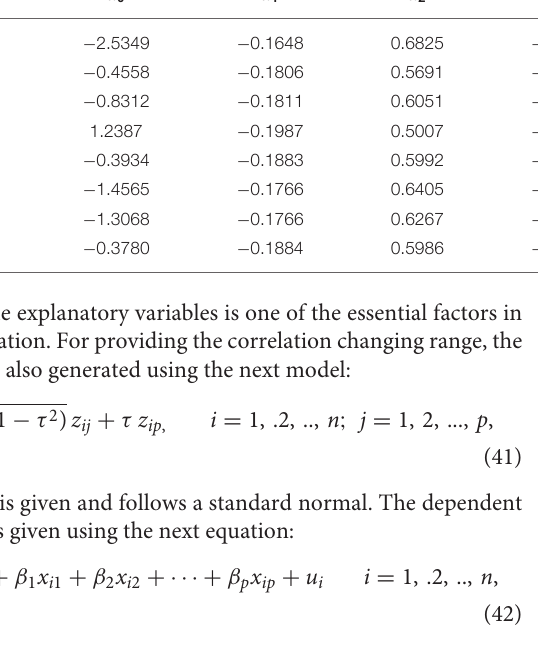
TABLE 8 | The regression coefficients and the MSE results.